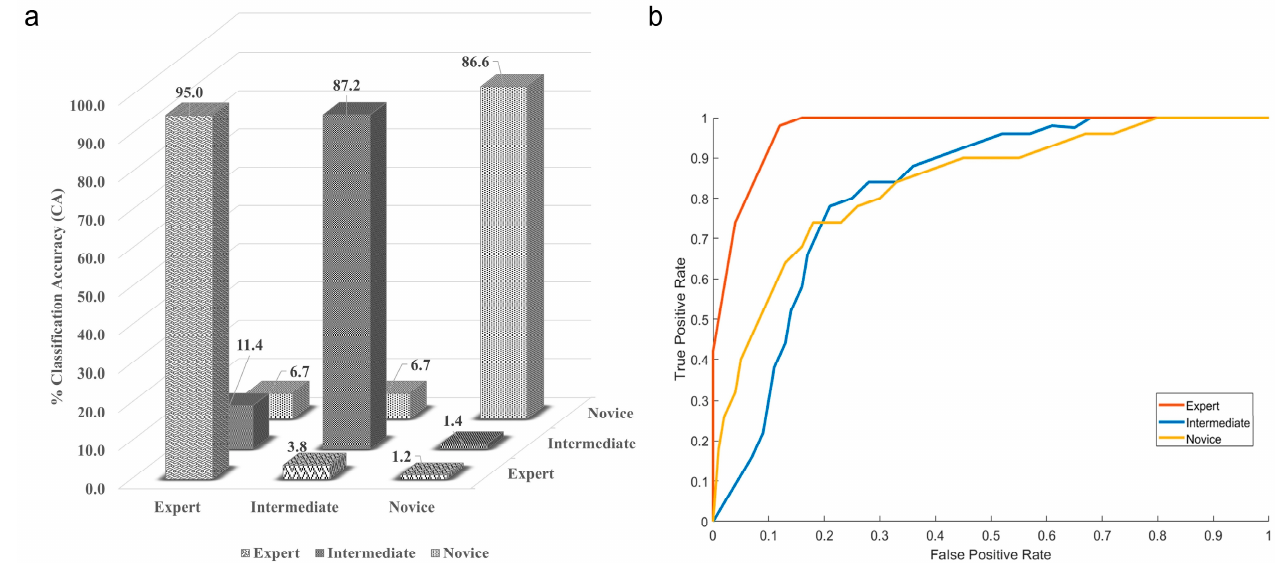
Figure 7. ( a ) Confusion matrix, ( b ) ROC curve for the highest performing naïve Bayes classifier.